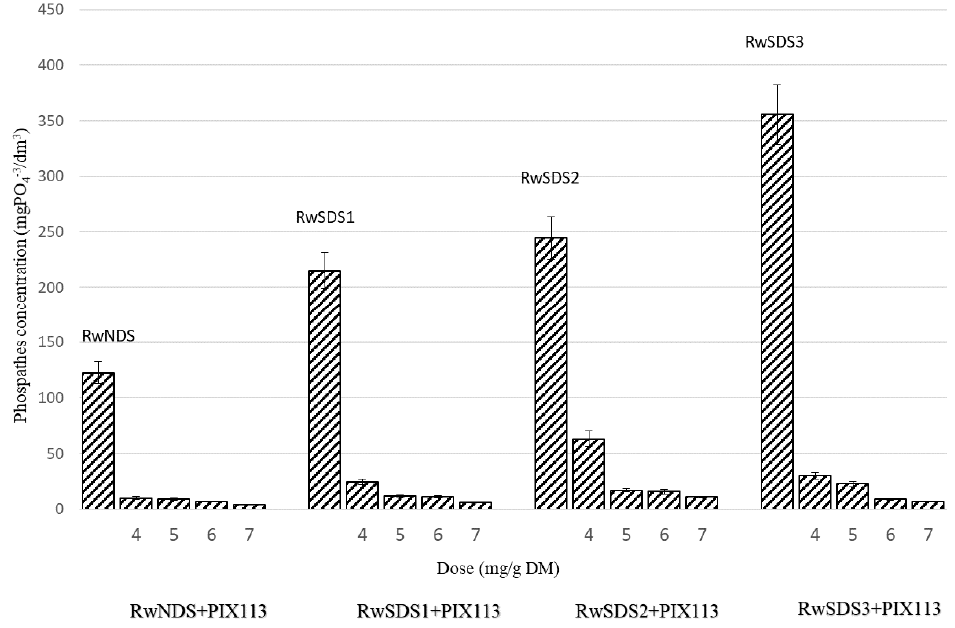
Figure 3. Changes of the COD in reject water separated from sludge prepared with Zetag 8180.